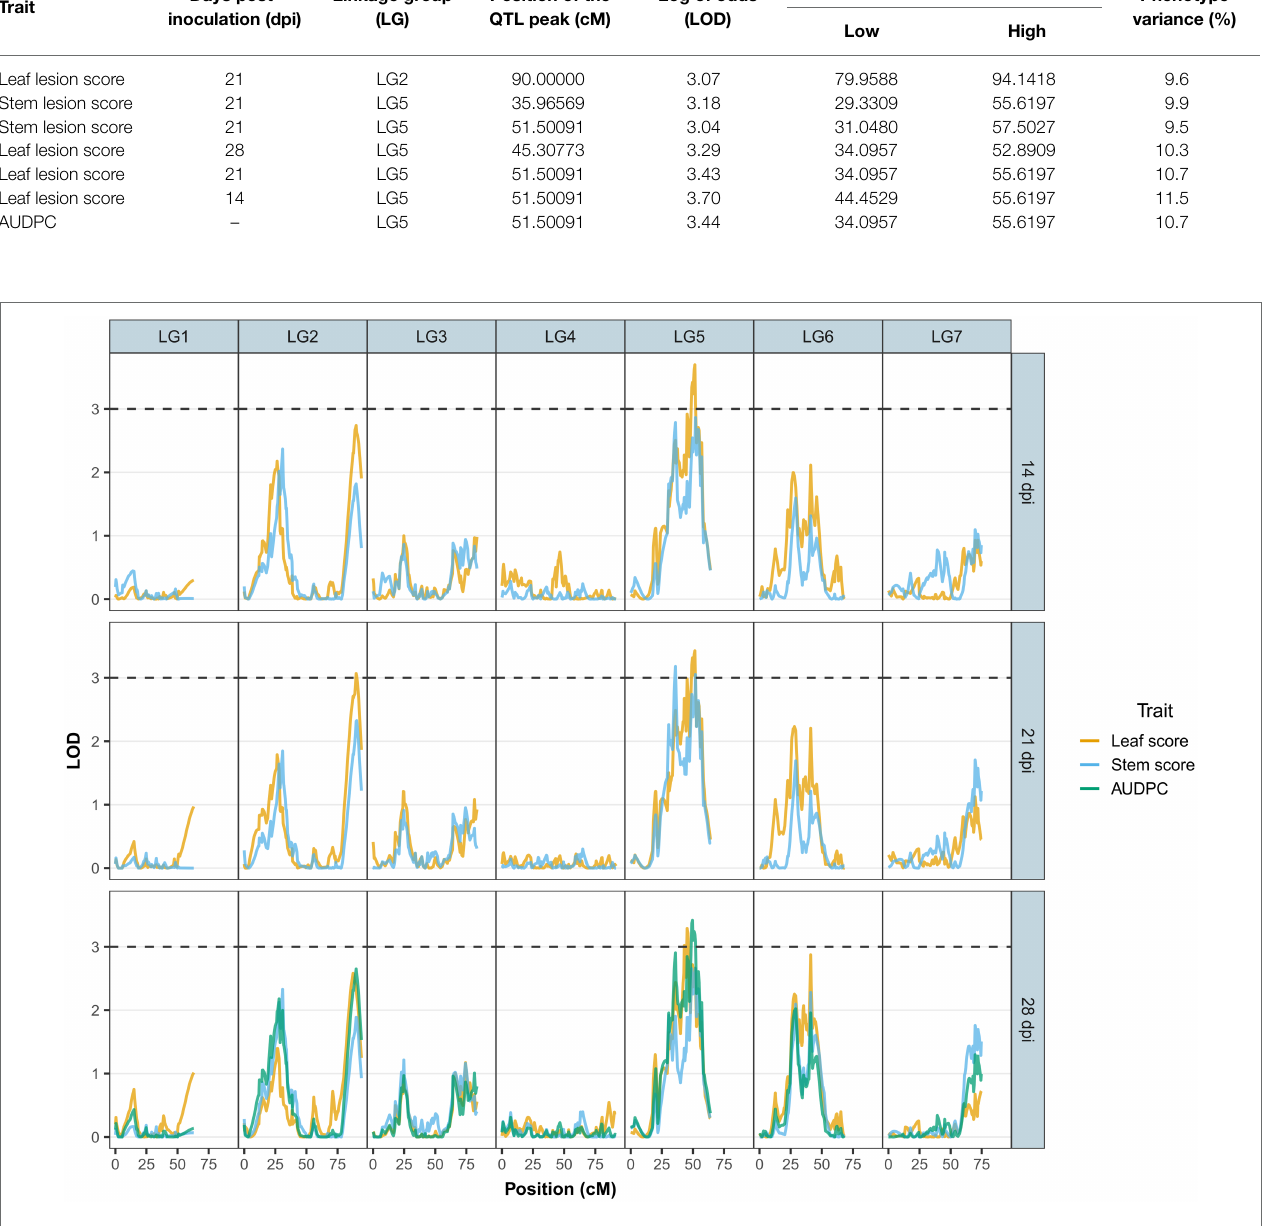
FIGURE 3 | LOD scores for Ascochyta blight disease symptoms (leaf lesions – yellow line and stem lesions – blue line) at 14, 21 and 28 days post-inoculation (dpi) and AUDPC (green line) at 28 dpi across the major linkage groups. Linkage group 8 is not presented due to its small number of markers with low LOD